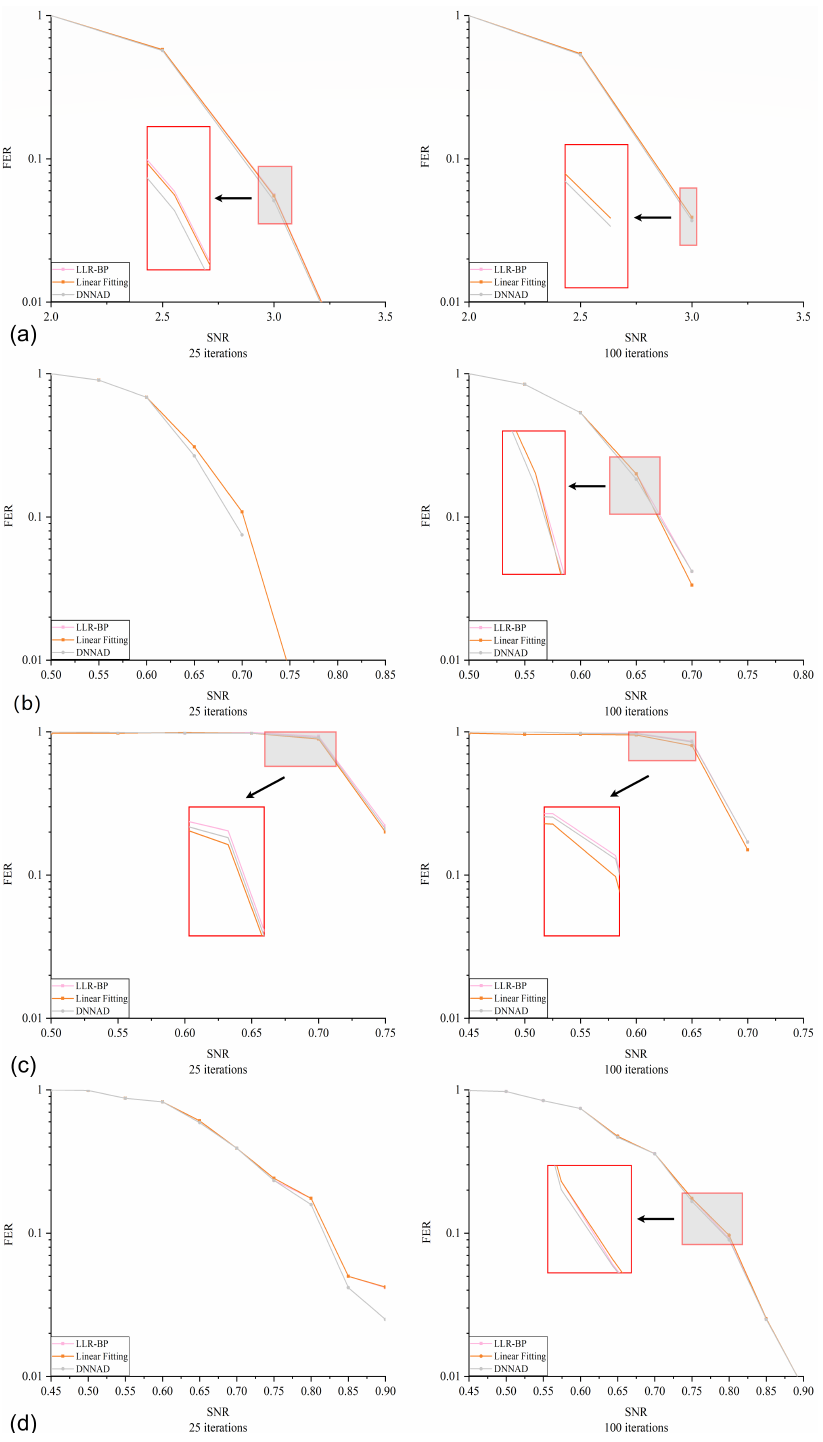
Figure 10. ( a ) The FER performance of ( 144,576 ) at 25 and 100 iterations. ( b ) The FER performance of ( 1408,1920 ) at 25 and 100 iterations. ( c ) The FER performance of ( 7040,9600 ) at 25 and 100 iterations. ( d ) The FER performance of ( 98304,131072 ) at 25 and 100